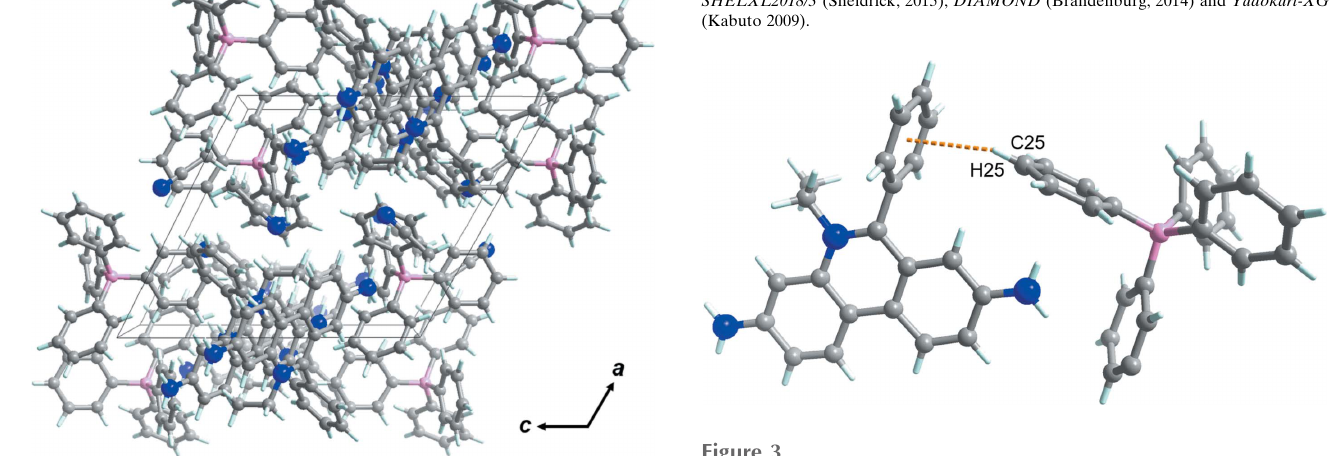
Figure 3 A short contact between the components with a C—H (cid:2)(cid:2)(cid:2) (cid:2) interaction, exemplified by ethidium and tetraphenylborate.